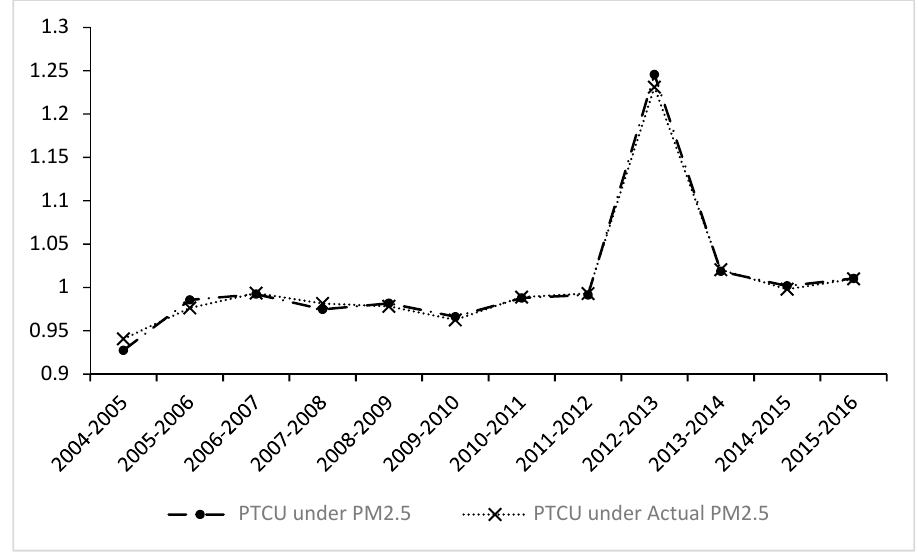
Figure 4. The dynamic trend of the pure technological catch-up (PTCU) index under PM 2.5 and actual PM 2.5 .